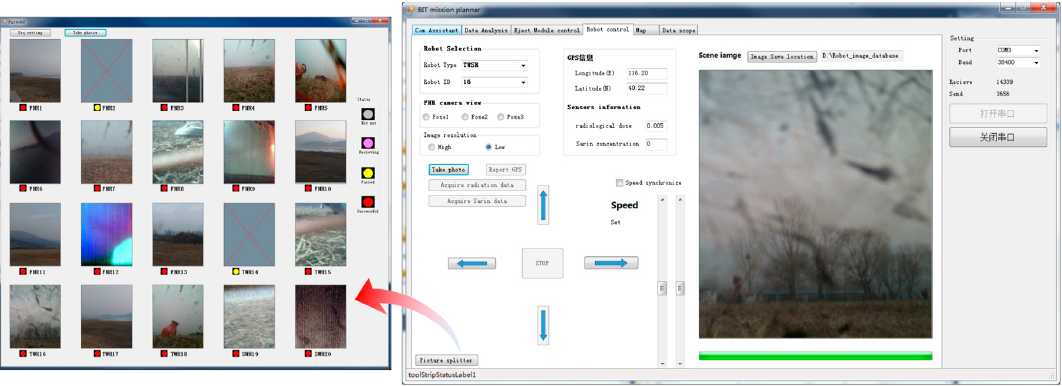
Figure 16. Disaster image information collected by the ground robots.